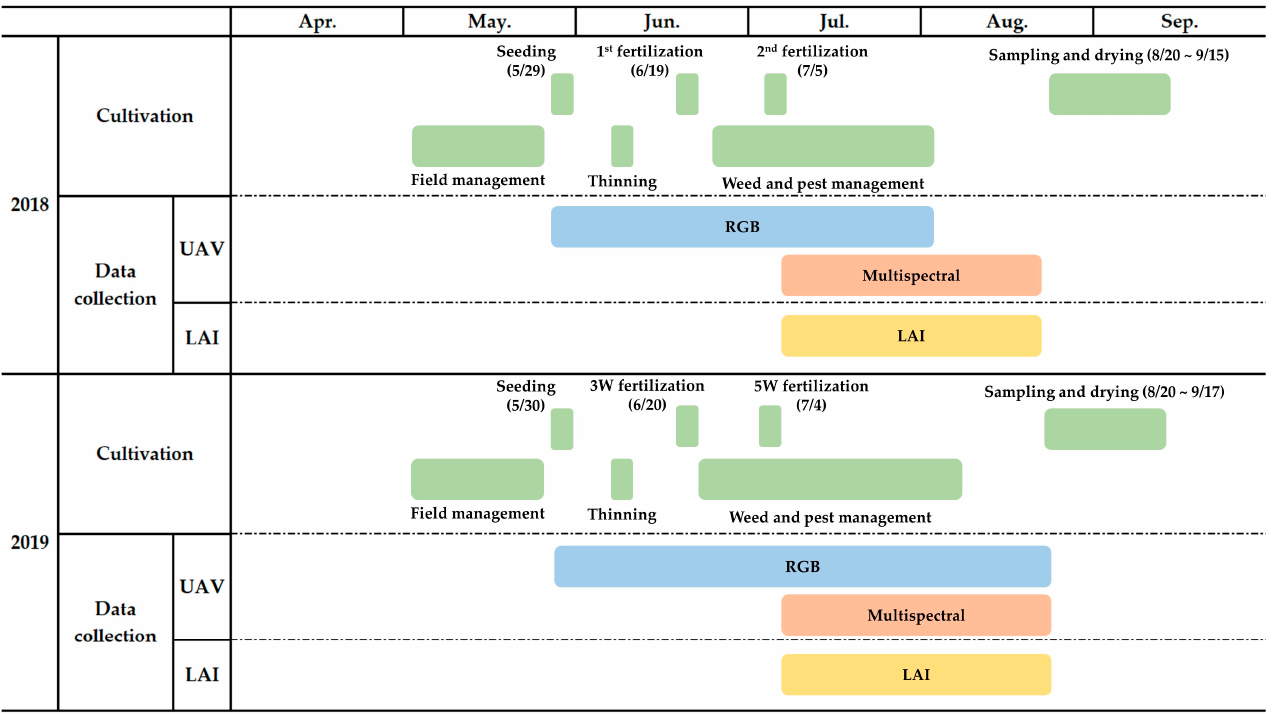
Figure 2. The chart for the description of sweetcorn cultivation and data collection during two consecutive vegetation seasons of 2018 and 2019.